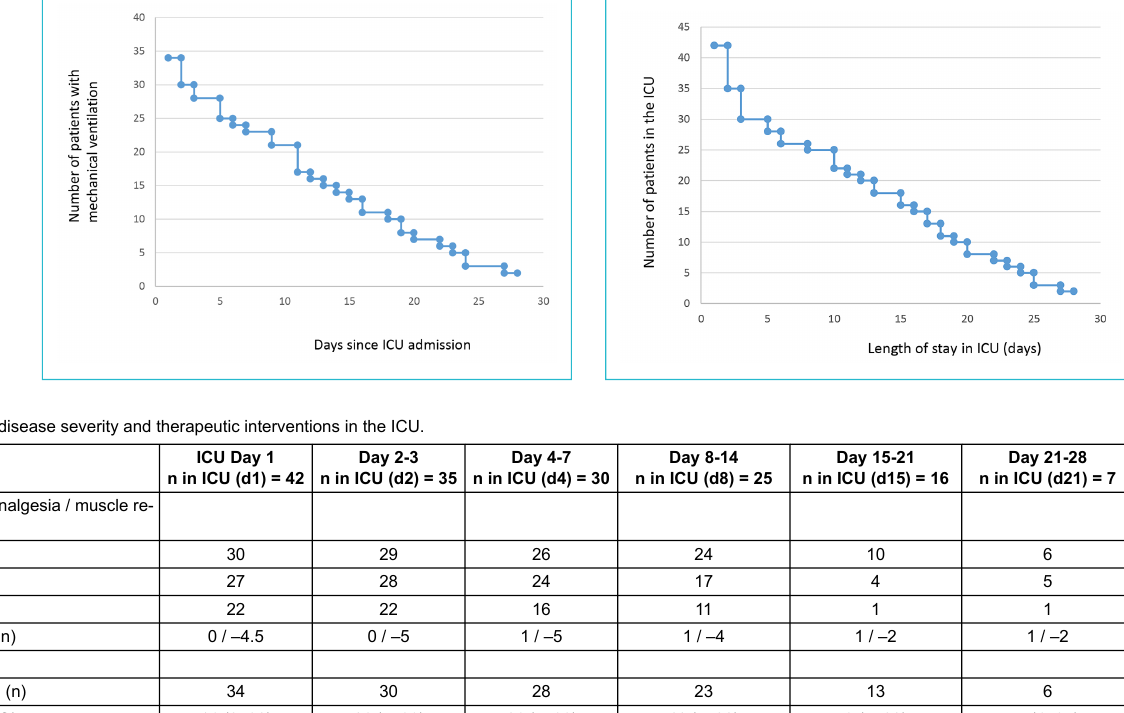
Figure 1: Length of mechanical ventilation. ICU = Intensive Care Unit. Figure 2: Length of intensive care unit (ICU) stay.